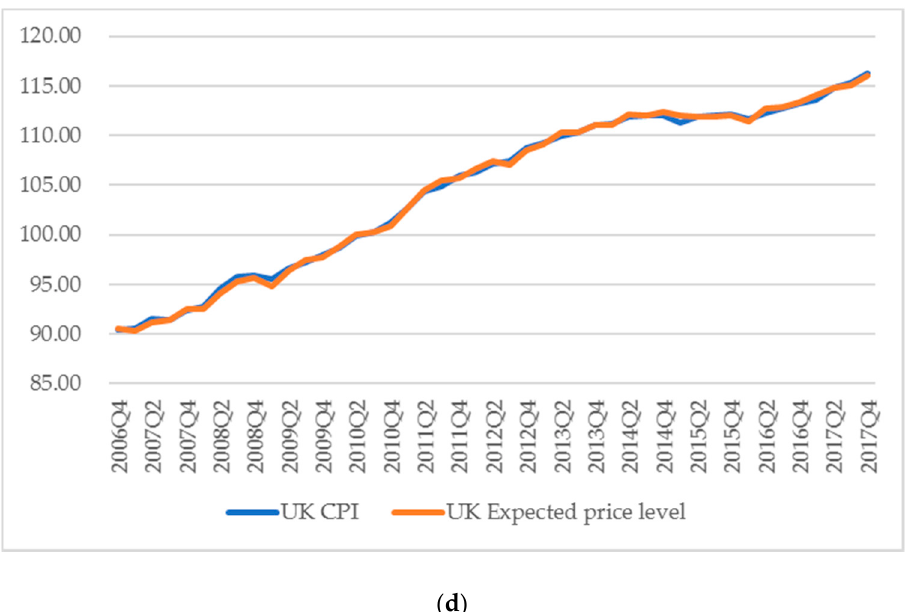
Figure 2. ( a ) CPI and expected price level in the United States. ( b ) CPI and expected price level in the euro zone. Notes: CPI is the weighted average of the original euro area. Weights are GDP share. ( c ) CPI and expected price level in Japan. ( d ) CPI and expected price level in the United Kingdom.